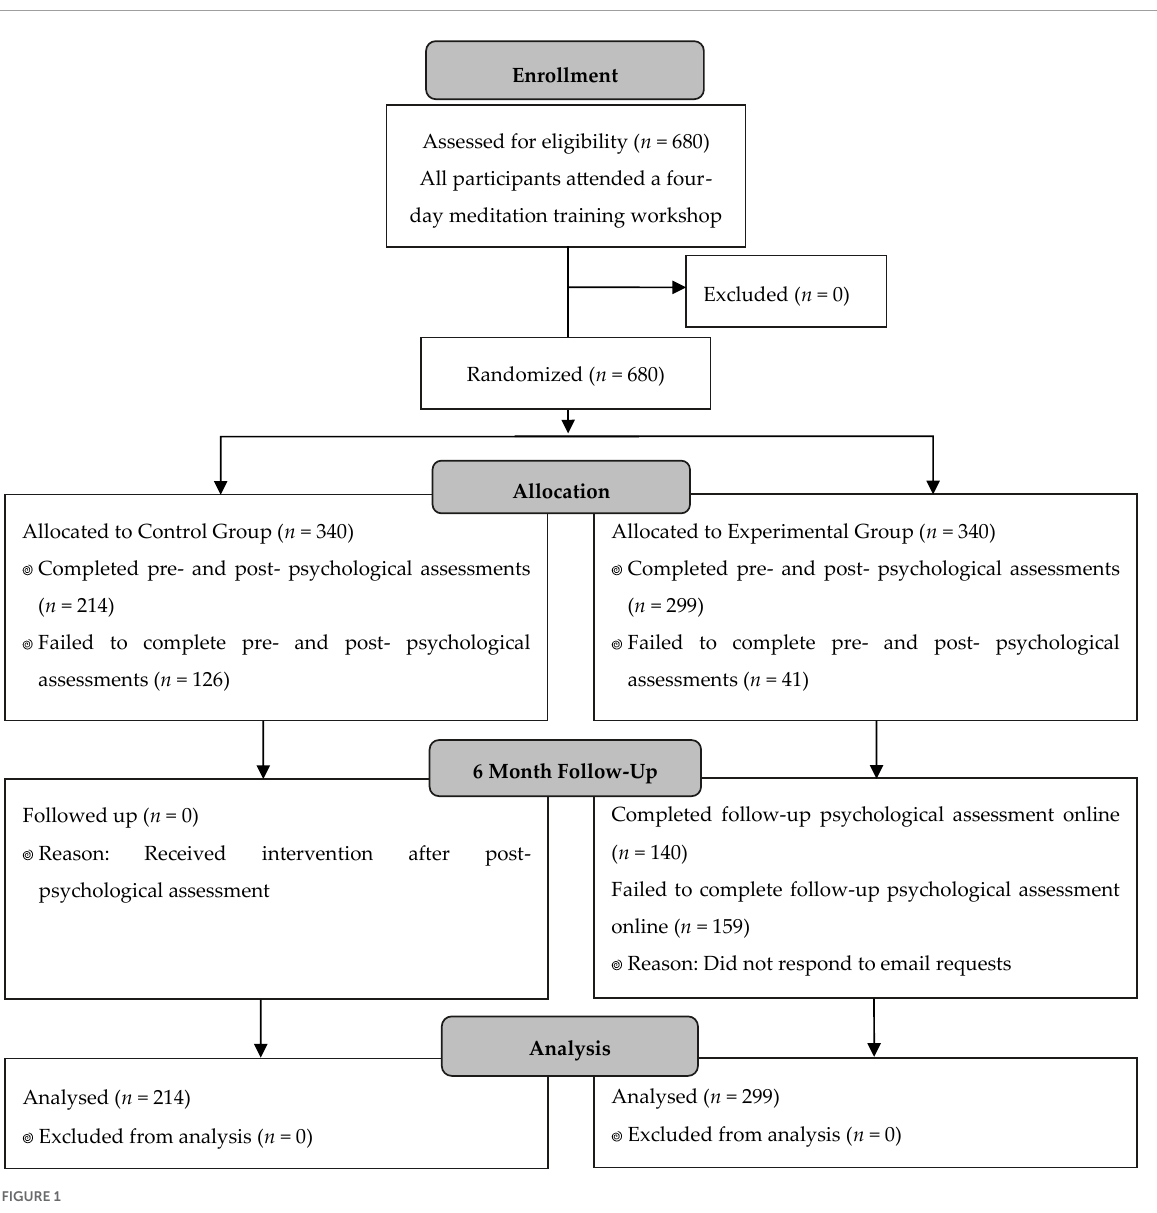
FIGURE1 CONSORT flow diagram of study